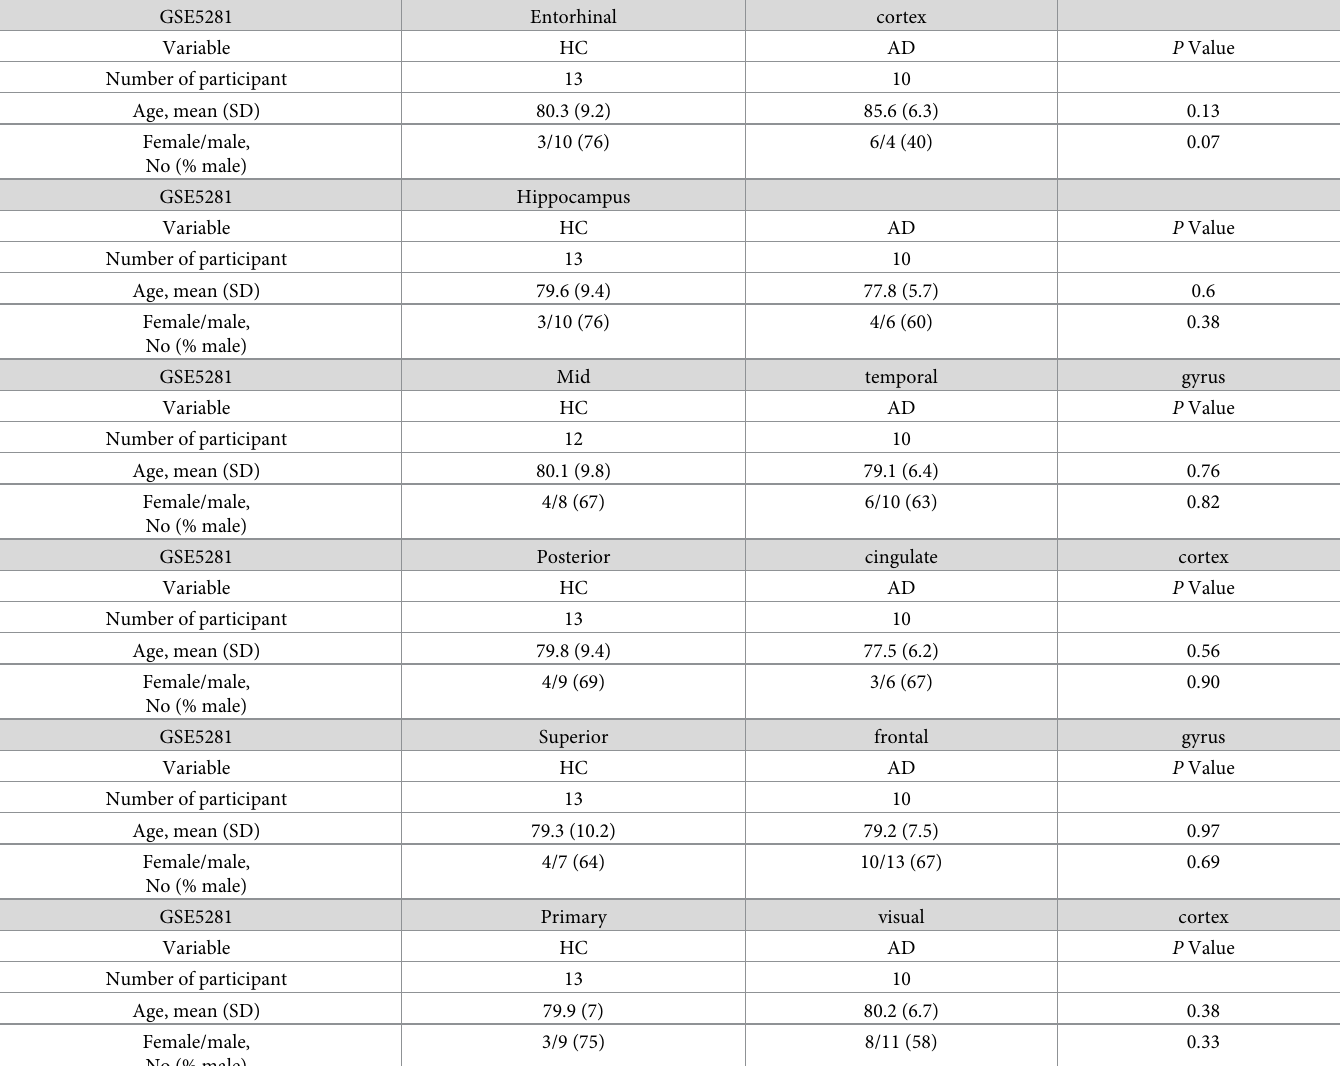
Table 1. Characteristics of study